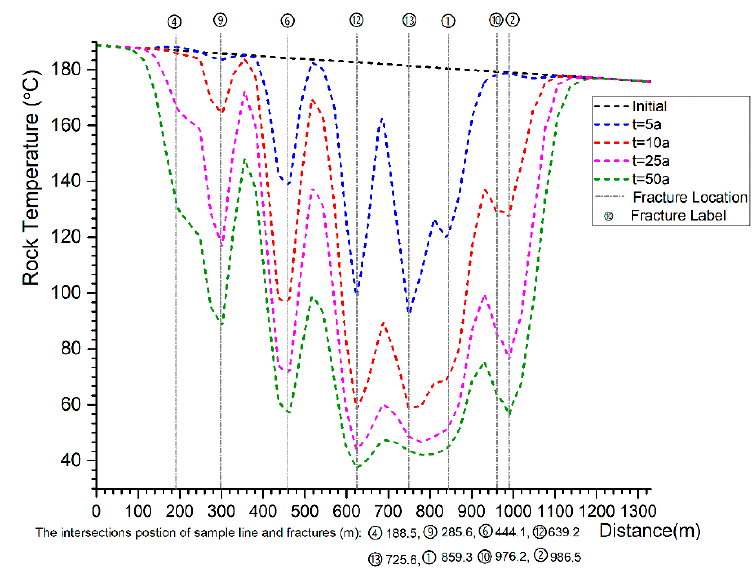
Figure 14. Temperature evolving in sample line 2 at injection rate of 136.6 kg/s.